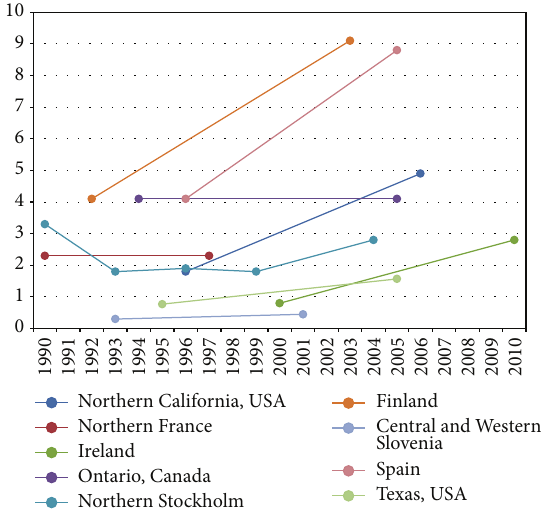
Figure 2: Incidence trends in pediatric Crohn’s disease from 1990